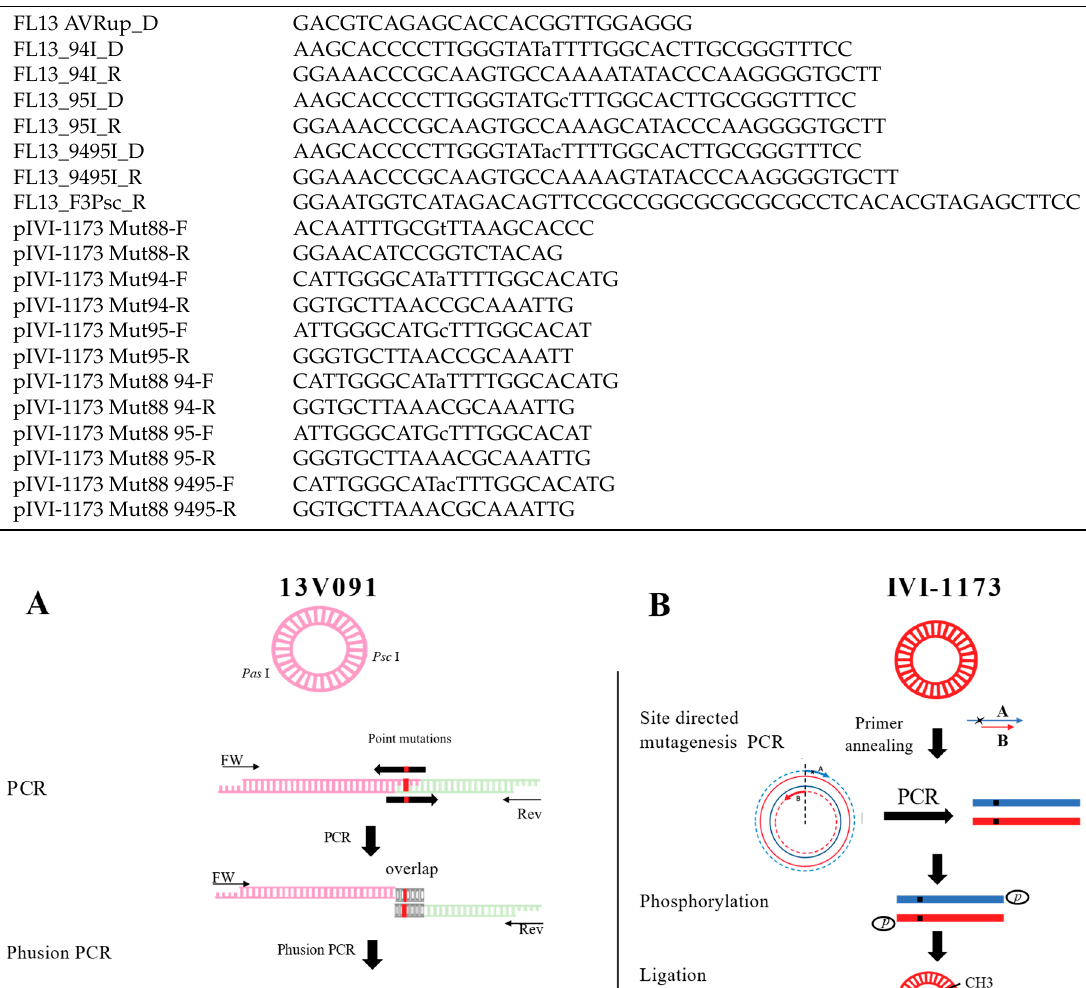
Table 1. Primers used for the mutagenesis of FL13 and IVI-1173 infectious clones. Name of the Primer